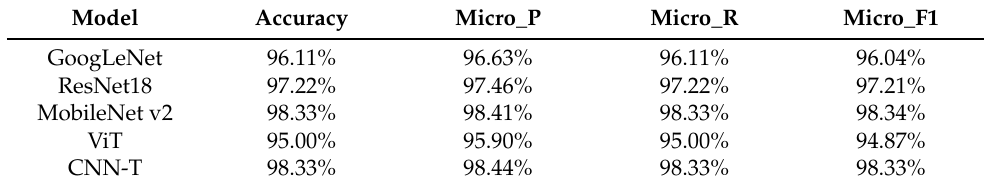
Table 1. Accuracy, precision, recall, and F1 of different models when the training ratio is 70%. Model